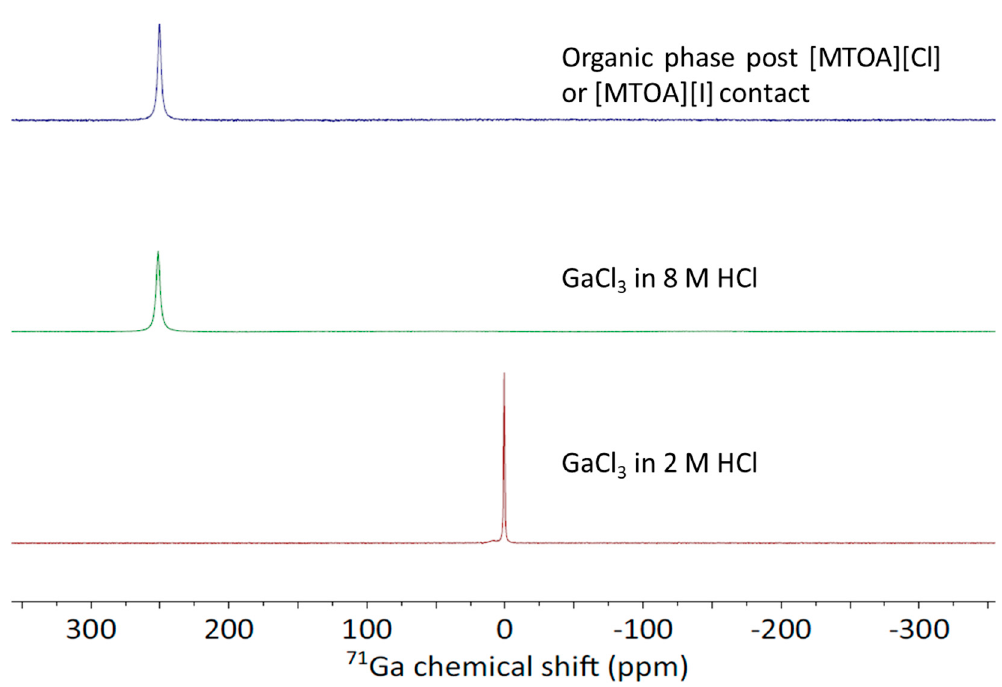
Figure 2. Top: 71 Ga NMR spectrum of 0.1 M [MTOA][I] or [MTOA][Cl] in toluene after contact with 0.01 M GaCl 3 dissolved in 2 M HCl. Middle: 71 Ga NMR spectrum of 0.01 M GaCl 3 dissolved in 8 M HCl. Bottom: 71 Ga NMR spectrum of 0.01 M GaCl 3 dissolved in 2 M HCl.